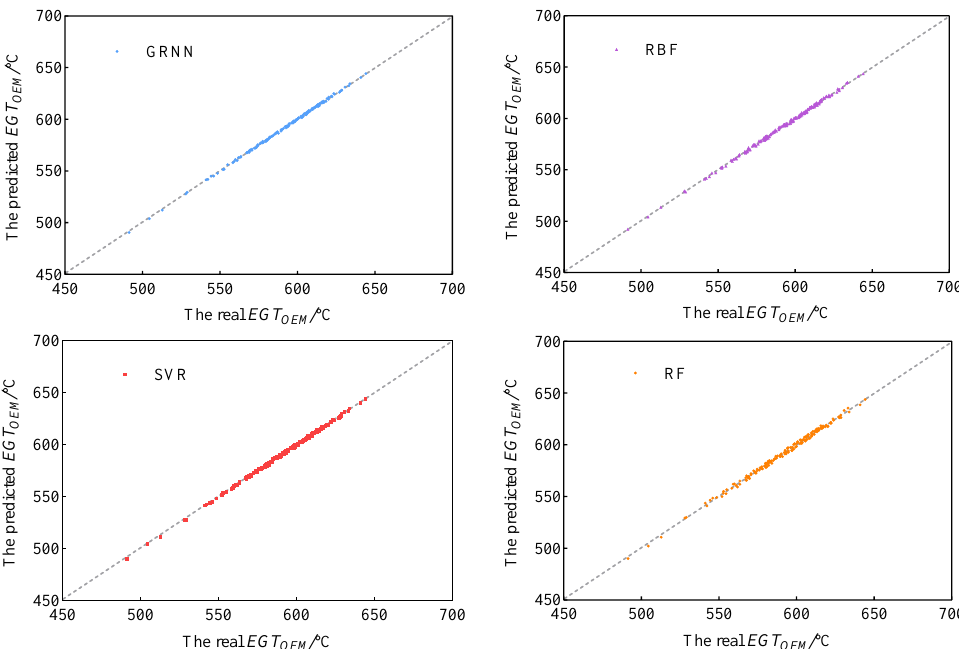
Figure 10. Prediction output of different models based on test data.